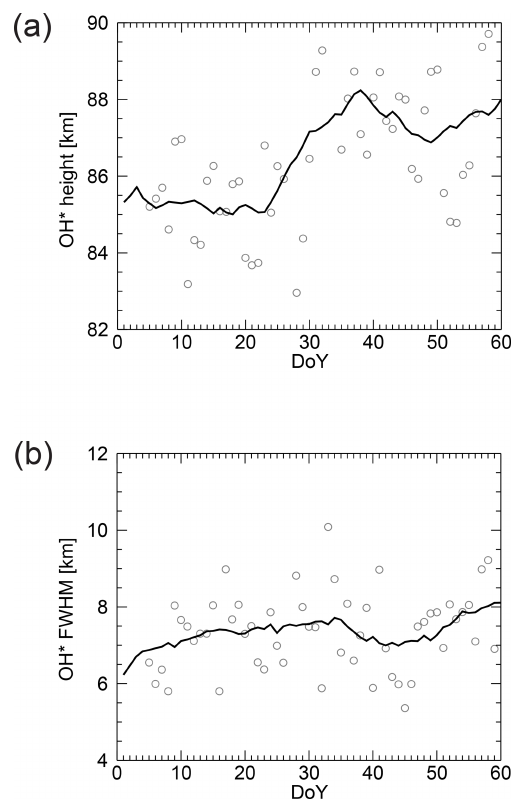
Figure 3. As in Fig. 2, the solid lines represent 15d running means of the OH* layer height (a) and its FWHM (b) . The circles stand for the individual values. Shown is the year